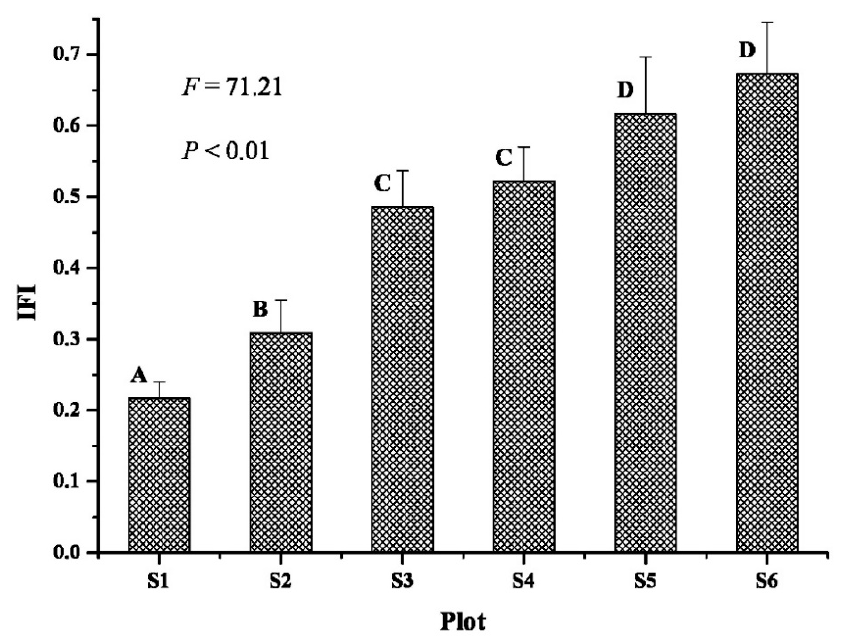
Figure 1. Soil fertility following irrigation with water of different salinity levels (S1, S2, S3, S4, S5, S6 refer to the plots with different salinity value mentioned in Table 1; A, B, C, D represents the result of a letter marker in a variety of comparisons).